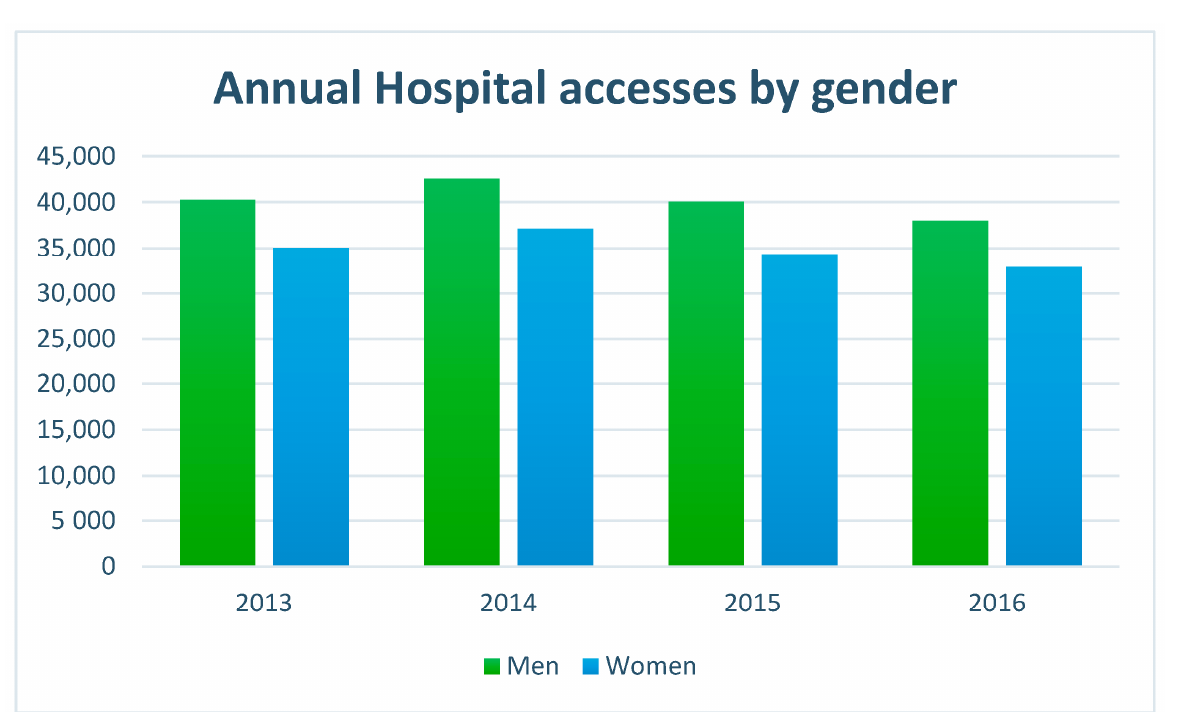
Figure 1. Annual hospital admissions in ER by gender.